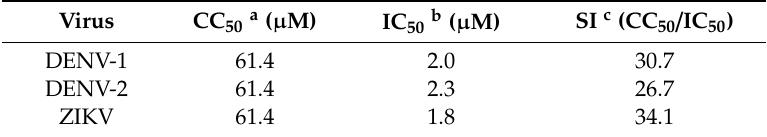
Figure 2. Antiviral activities of compound L3 against DENV-1, DENV-2, and ZIKV in HEK-293 cells. HEK-293 cells were infected with DENV-1, -2, or ZIKV with or without (solvent) various concentrations of compound L3 for 36 h. ( A ) Viral protein levels were determined by Western blot analysis. Actin or GAPDH was used as a loading control. Relative ratios of viral NS3 or E protein levels to actin or GAPDH levels were adjusted to those of the solvent control. ( B ) The viral progeny production in the culture supernatants was measured by a focus-forming assay. Data are the mean ± SD of three independent experiments. * p < 0.05, ** p < 0.01, *** p < 0.001 according to a two-tailed Student’s t -test. Table 1. Cytotoxic concentrations and inhibitory concentrations of compound L3 applied for 36 h to HEK-293